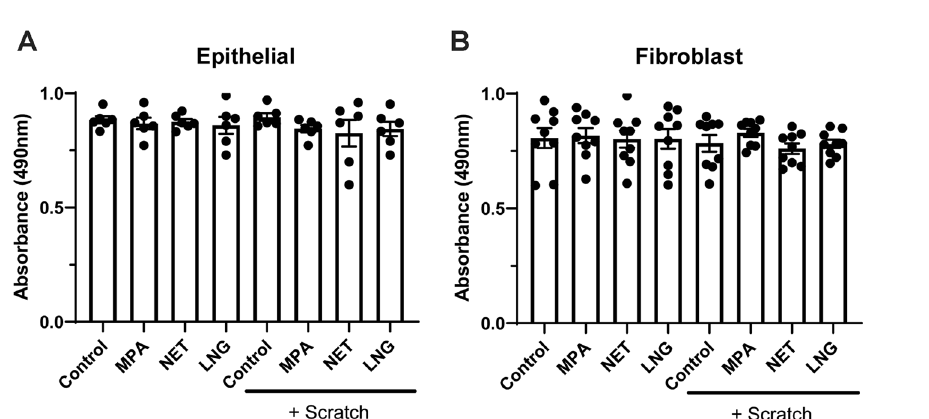
Figure 5. Wound closure is not accompanied by cell proliferation over 48 h. Cell proliferation following injury of (A) endometrial epithelial cells grown in transwell inserts and (B) endometrial stromal fibroblasts grown in 24-well plates. Cells were treated with MPA, NET, or LNG at 100 nM for 48 h prior to scratch, and maintained in cell culture media at 100 nM following scratch. Cell proliferation was determined using a CellTiter cell proliferation assay performed 48 h post-scratch. Bars represent mean + /− SEM. Each symbol represents a single individual (epithelial cell n = 6 ; stromal fibroblast n = 9